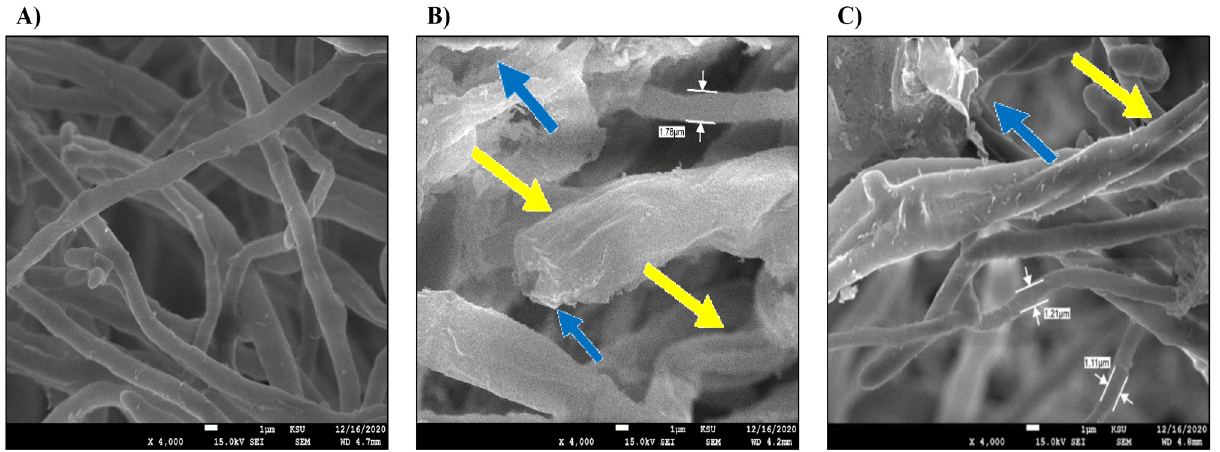
Figure 7. SEM images of the fungal growth of M. phaseolina . The treated fungus had swelling (yellow arrows) and rapture (blue arrows) of conidial surface compared to the control: ( A ) untreated control, ( B ) effect of the water extract of T. aphylla , ( C ) effect of the ethanolic extract of T. aphylla . Similarly, TEM showed ultrastructural changes in the fungal growth of M. phaseolina in response to treatments by T. aphylla extracts. The untreated biomass (control) of M. phaseolina had natural mycelial and conidial structures with distinguishing internal characterizations as represented in the left panel of the TEM micrographs. The right panel shows that both treatments caused the accumulation of large white vacuoles. Those vacuoles caused the rapture of the cellular wall, which might illustrate the inhibitory effects of the mycelial growth of M. phaseolina by T. aphylla extracts (Figure 8).